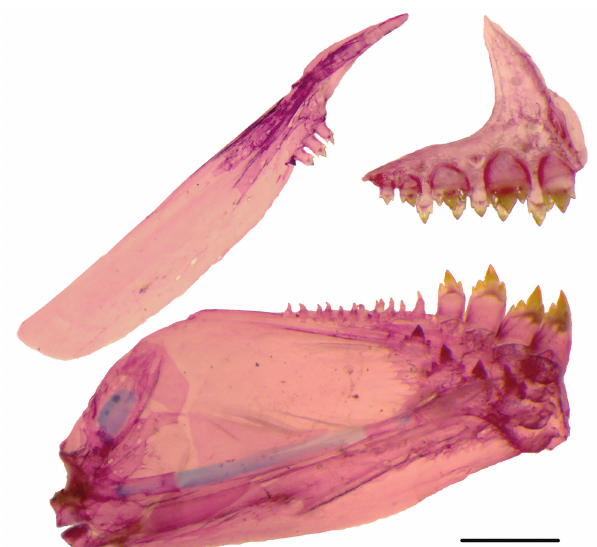
Fig. 2. Medial view of left side of premaxilla, maxilla and dentary of Moenkhausia parecis , MZUSP 116071, paratype, 26.2 mm SL. Scale bar = 1 mm.